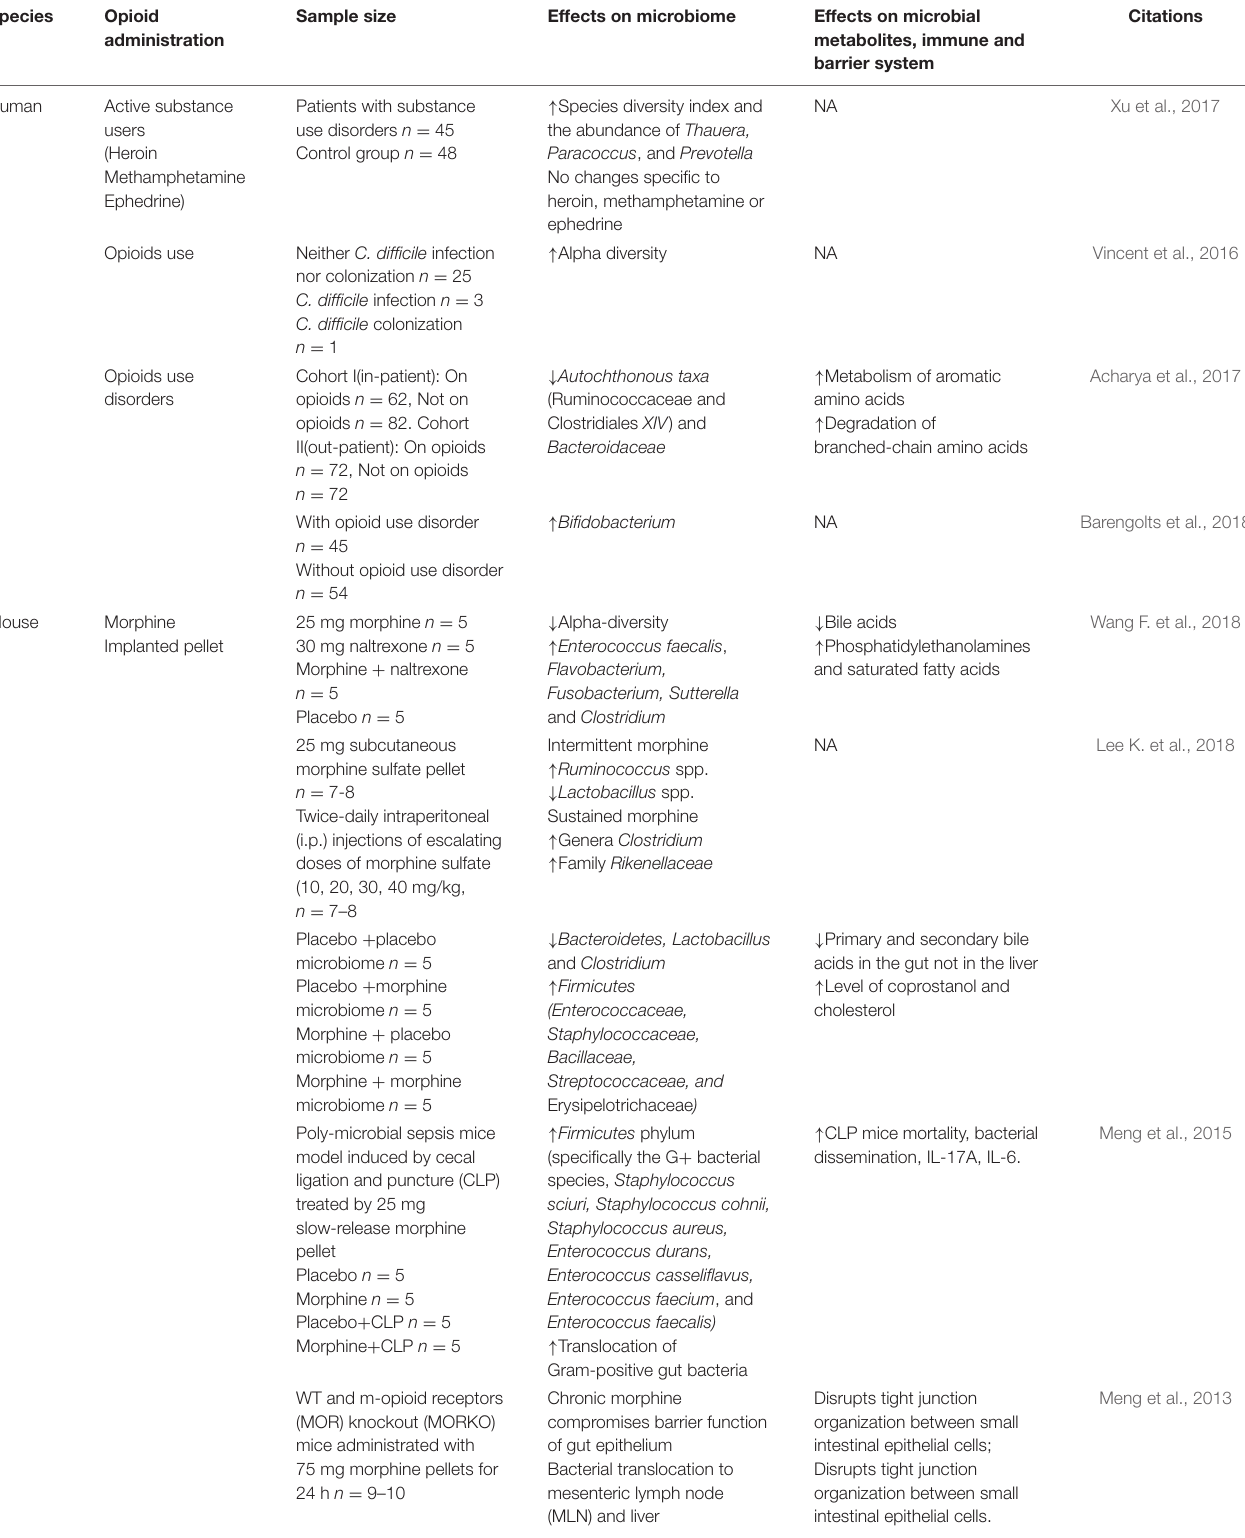
TABLE 4 | Effects of opioid on gut microbiome and other